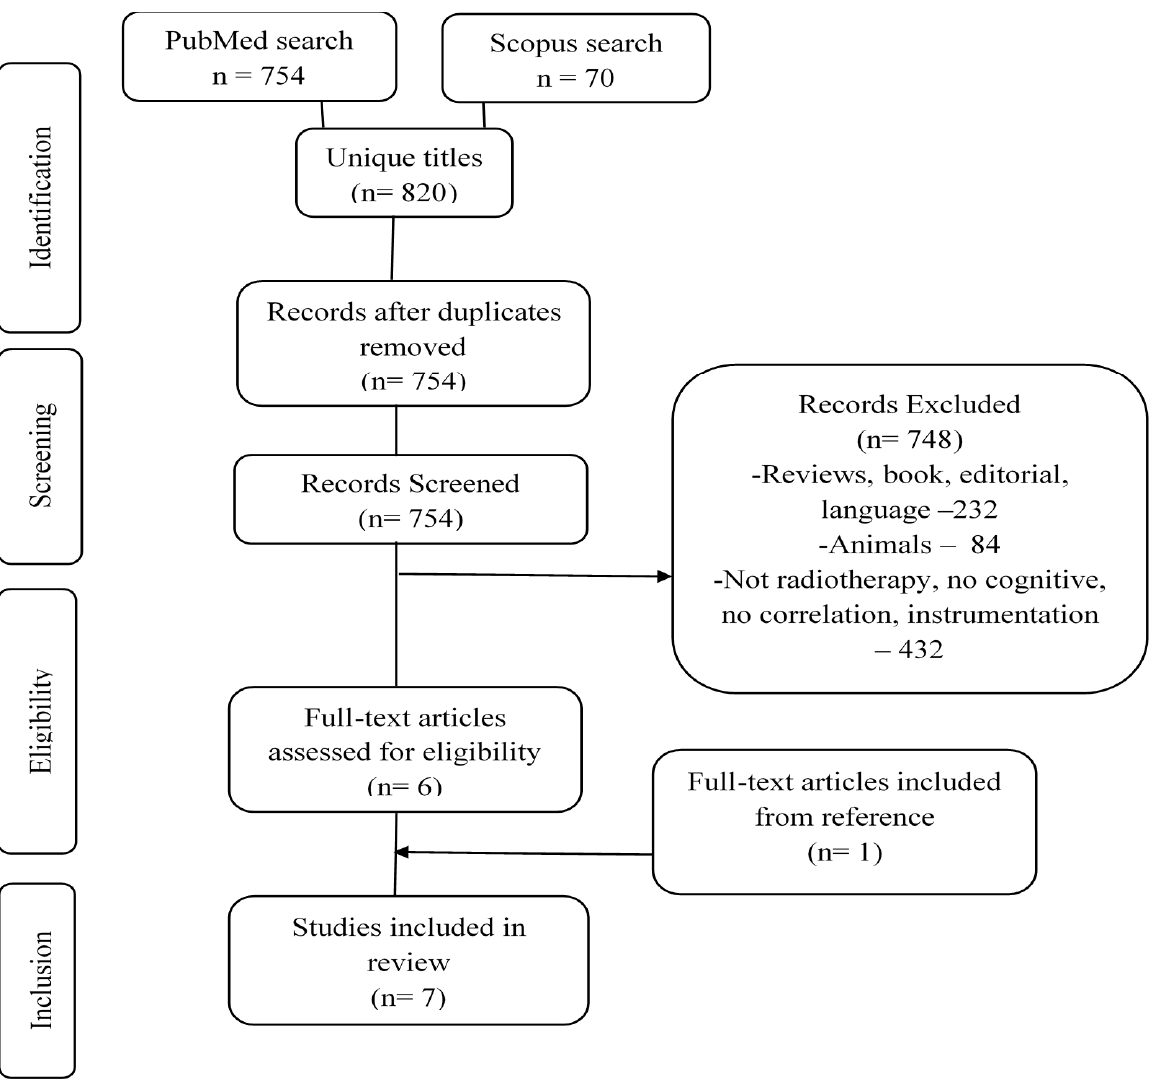
Figure 1. Search strategy via Preferred Reporting Items for Systematic Reviews and meta-analyses guidelines .